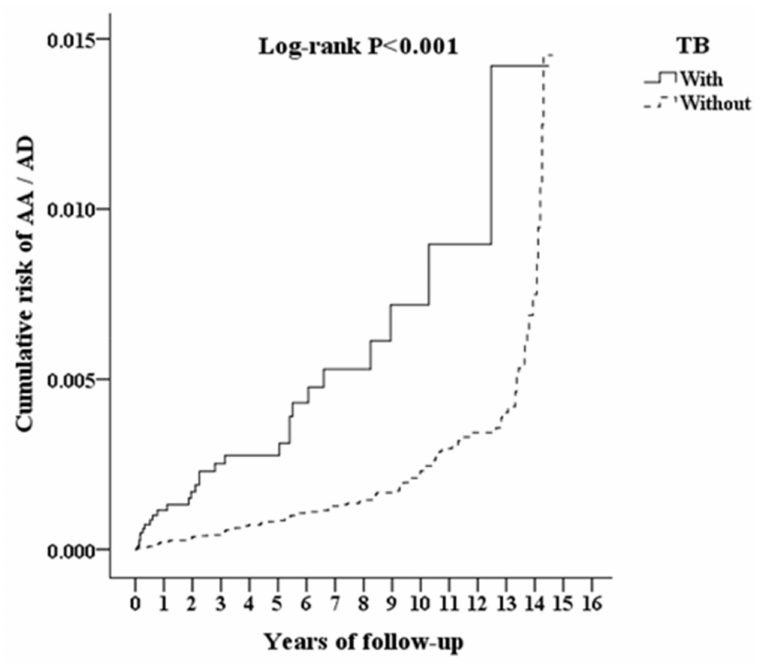
Figure 2. Kaplan–Meier curve for the cumulative risk of aortic aneurysm and aortic dissection due to tuberculosis. TB = tuberculosis, AA = aortic aneurysm, AD = aortic dissection.